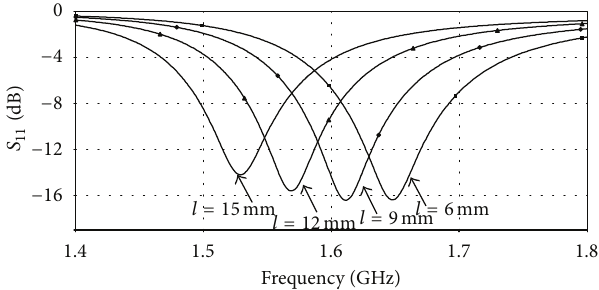
Figure 6: 𝑆 11 parameter of the PIFA for different stub